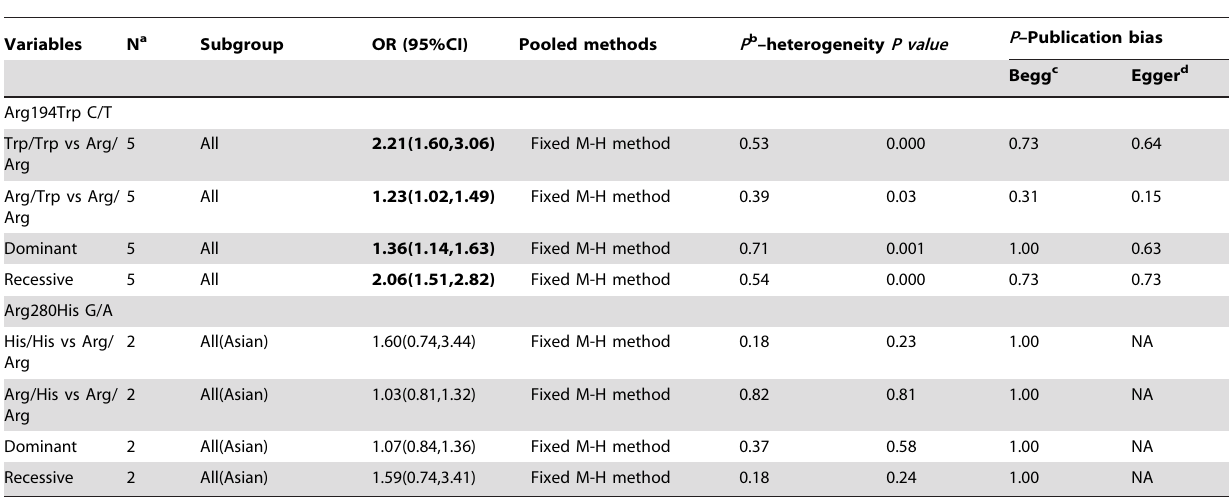
Table 2. The XRCC1 Arg194Trp and Arg280His polymorphisms on CC risk.